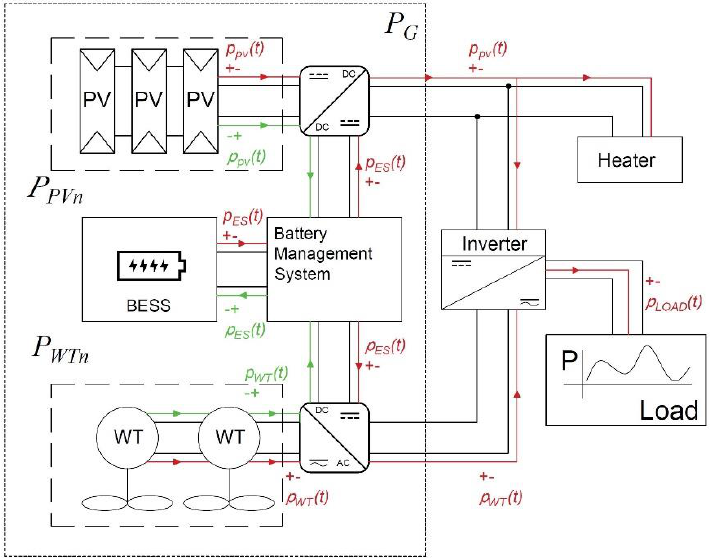
Figure 3. Illustrative diagram of a PV—wind hybrid power supply system with electrochemical energy storage (PV—photovoltaic modules, WT—wind turbines, BESS—battery energy storage system, P—load, DC/DC, AC/DC—inverter systems working directly with the PV and wind part).